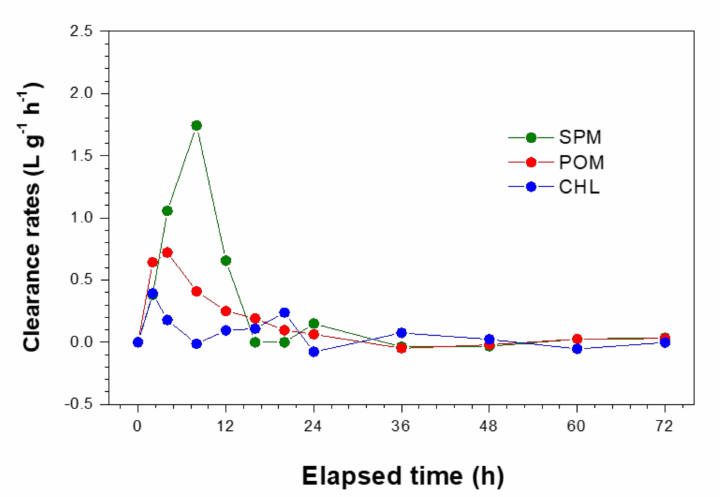
Figure 3. Clearance rate (L g − 1 h − 1 ) of Unio douglasiae for suspended particulate matter (SPM), particulate organic matter (POM), and chlorophyll- a (CHL). Each value is the average of three subsamples (standard errors are presented in